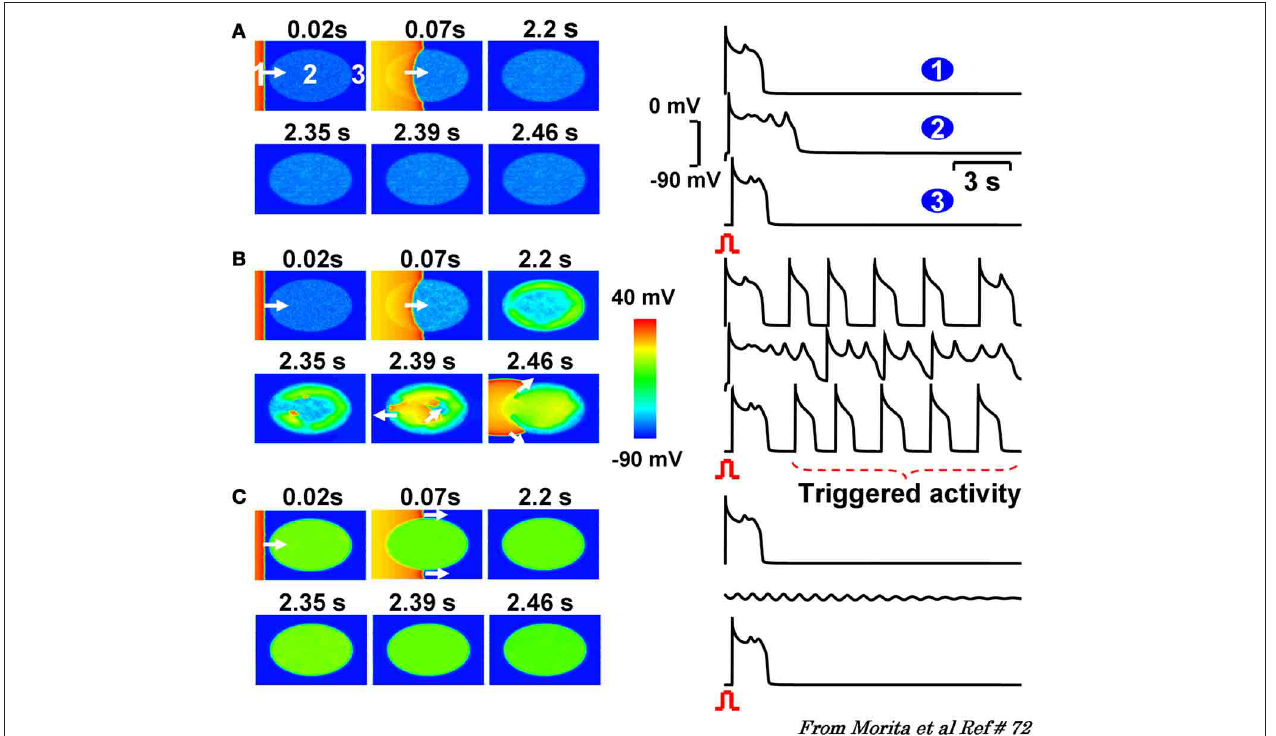
FIGURE 7 | 2D simulations in a tissue with progressive regional increase in the number of fibroblasts to myocyte gap junction couplings. Panels (A–C) are voltage snap shots after a paced beat from the left border of the tissue (red) with central ellipse (site 2) representing the region of progressive increase in fibroblast to myocyte (F-M) coupling ratio. In panel (A) with F-M ratio of 1, promotes small amplitude non-propagating EADs. Similar dynamic scenario is also observed when the F-M ratio in the ellipse is raised to 3 as shown in panel (C) . After the